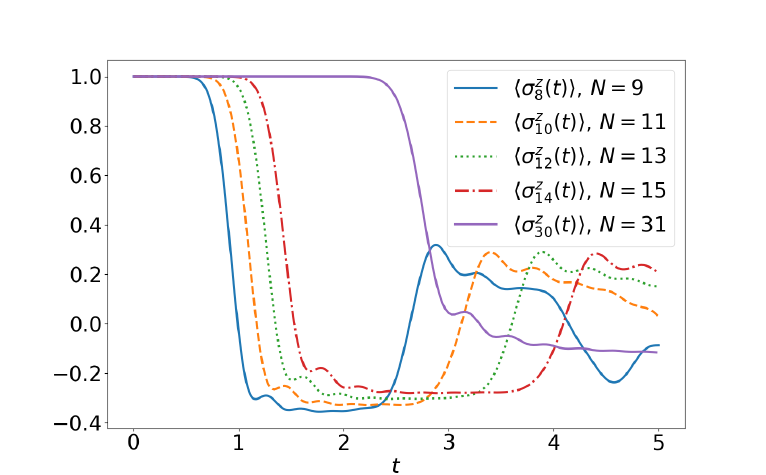
Figure 4: The Z expectation value vs. t , of the qubit at the right end of the chain (at the other edge from the driven qubit), for chains of varying length from N = 9 to N = 31. The parameters are given in Eq. (31) and Eq. (32). The near self-similarity with shifts in time and Z depth (linearly dependent on N ) can be seen. See the text for a detailed